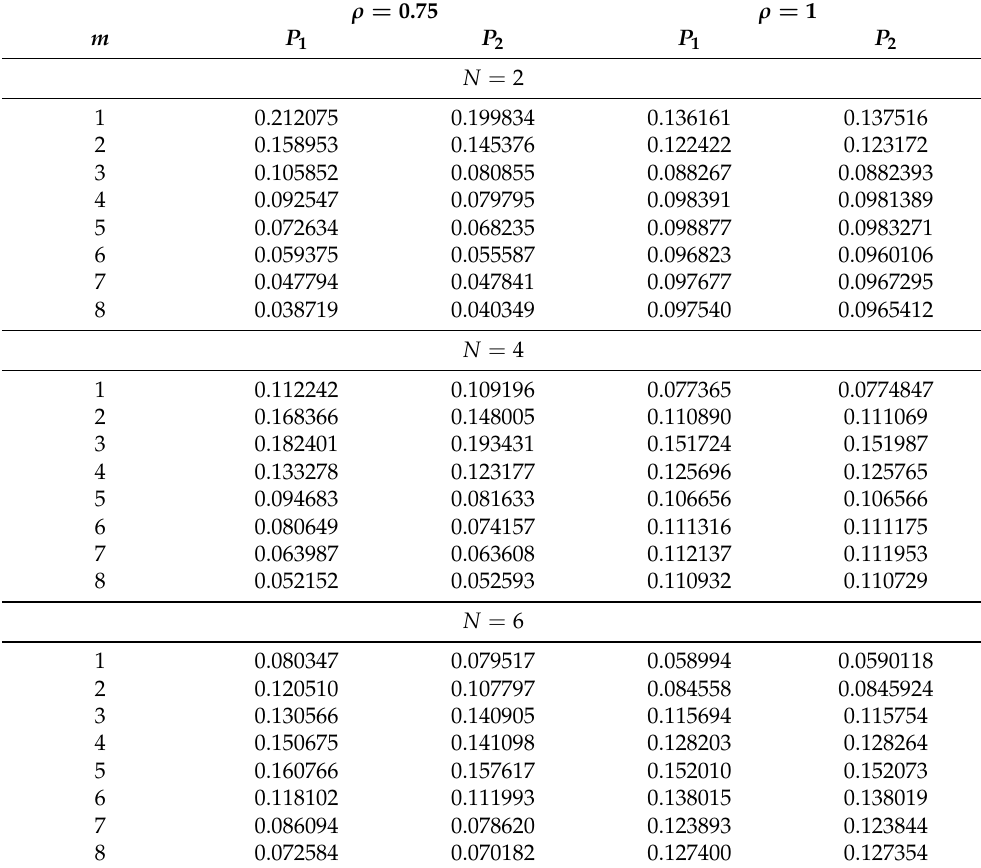
Table 1. Stationary probability distributions P { X ( ∞ ) = m } for N = 2,4,6, utilization factors ρ = 0.75, ρ = 1 and batch distributions P 1 , P 2